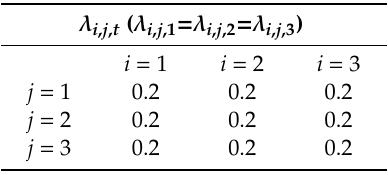
Table A4. Percentage (%) of demand expressing the maximum shortage allowed (considered here the same for any time period).